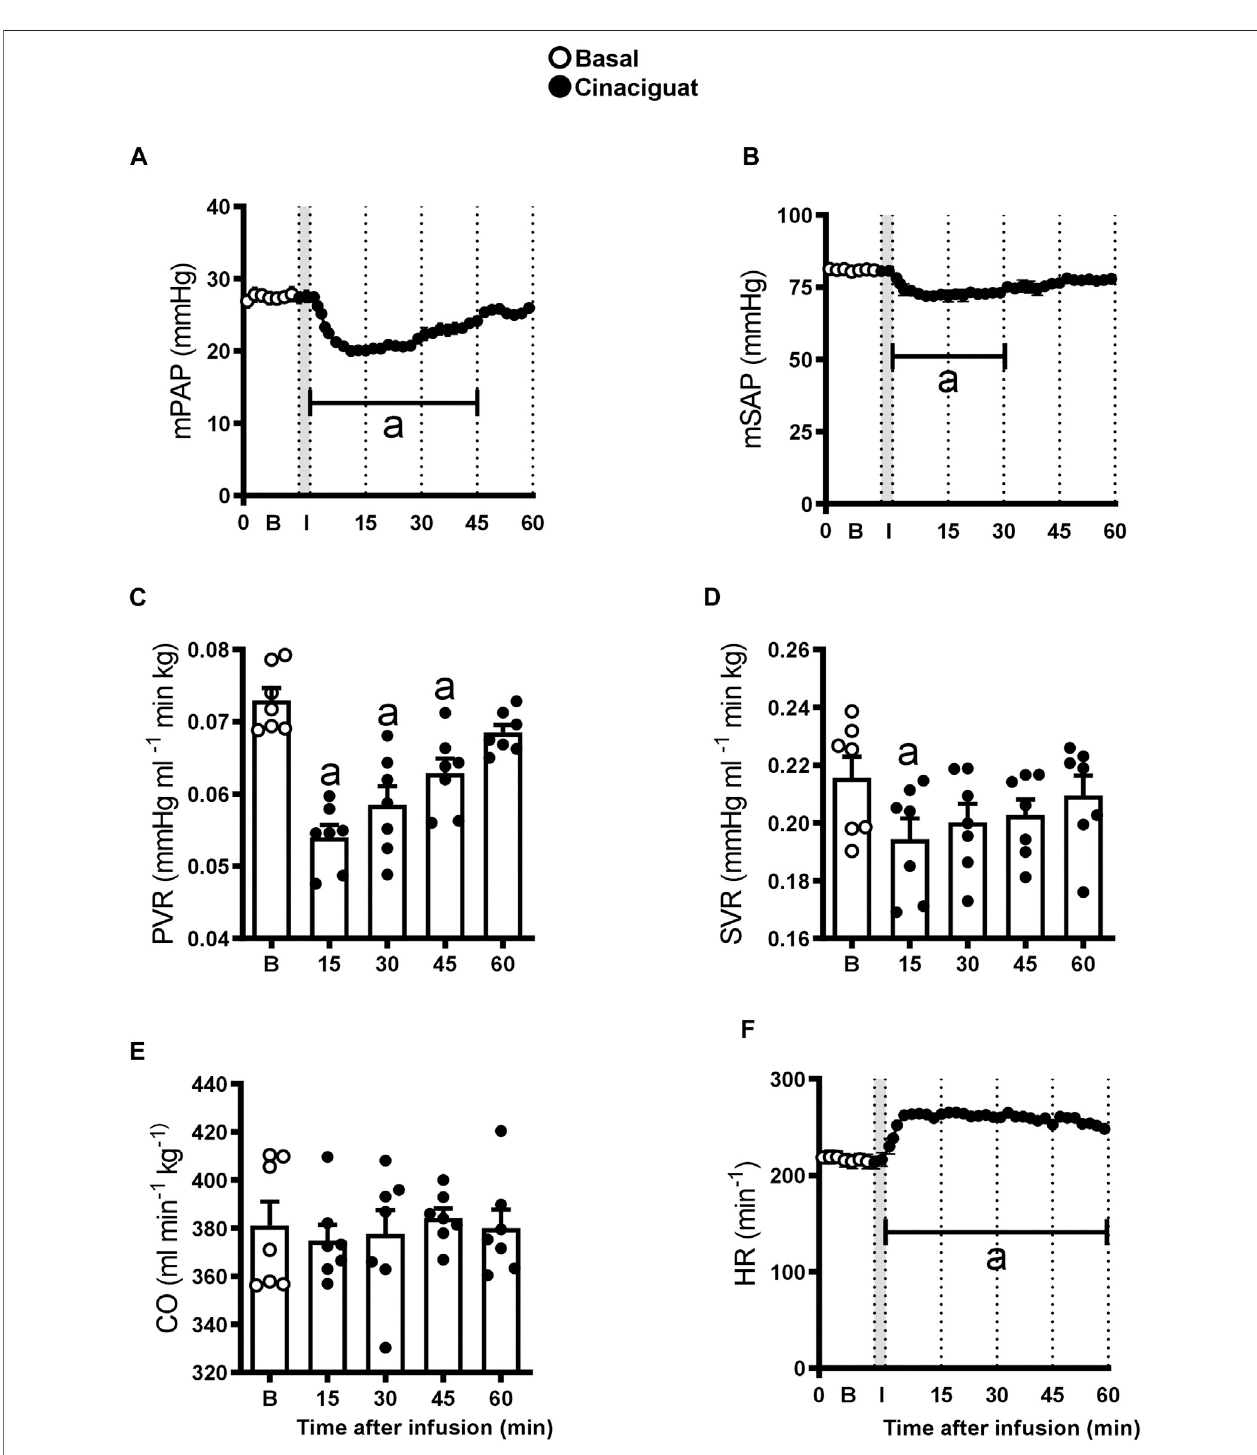
FIGURE 1 | Acute effects of a 3 min infusion of Cinaciguat on the cardiopulmonary and systemic circulations of 6 chronically hypoxic and pulmonary hypertensive neonatal lambs. Infusions were performed in 7 successive days and results are means ± SEM of each variable at indicated times. Open circles: Basal values (B) ; Black circles, values after Cinaciguat infusion. Mean pulmonary arterial pressure [(mPAP, (A) ], mean systemic arterial pressure [mSAP, (B) ]; pulmonary vascular resistance [PVR, (C) ]; systemic vascular resistance [SVR, (D) ]; cardiac output [CO, (E) ], and heart rate [HR, (F) ] were recorded for 60 min. In the X axis, B, basal; I, infusion. Signi fi cant differences ( p ≤ 0.05): a vs. basal period.